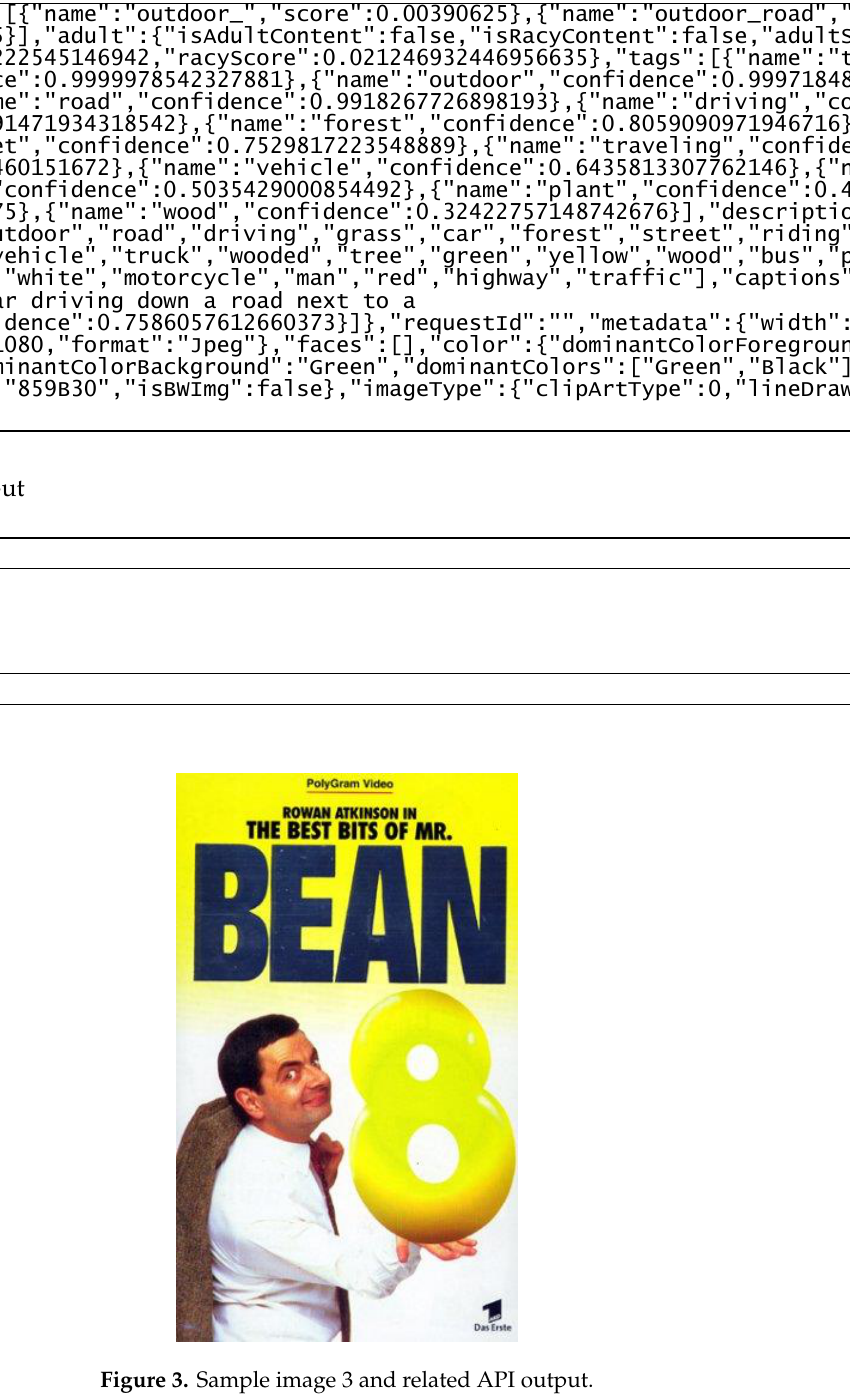
Figure 2. Sample image 2 and related API output.